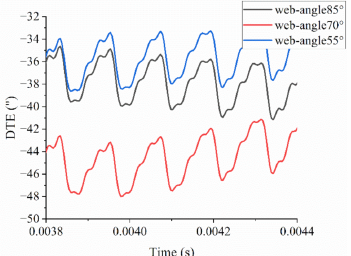
Figure 10. Dynamic transmission errors of models with different web support